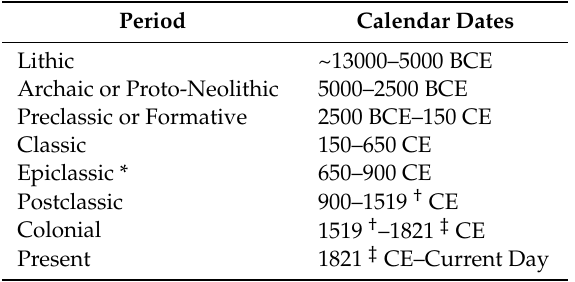
Table 1. Mesoamerican chronology: BCE (Before Common Era); CE (Common